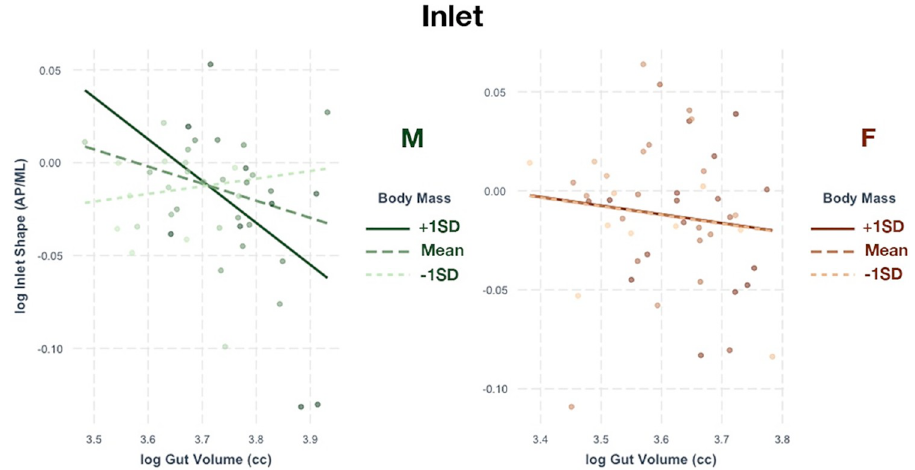
Fig 3. Relationship of inlet shape with gut volume. Regressions between gut volume and pelvic canal shape at the inlet relative to body mass. The male sample (left, green) shows a significant relationship. To visualize the effect of body mass on the variables, the plots shown here separate the data points into three groups: those with body masses below 1 SD from the mean (lightest color), those with body masses above 1 SD from the mean (darkest color), and those with body masses between -1 SD and +1 SD from the mean (medium color). The regression lines are the best fit lines for each group.